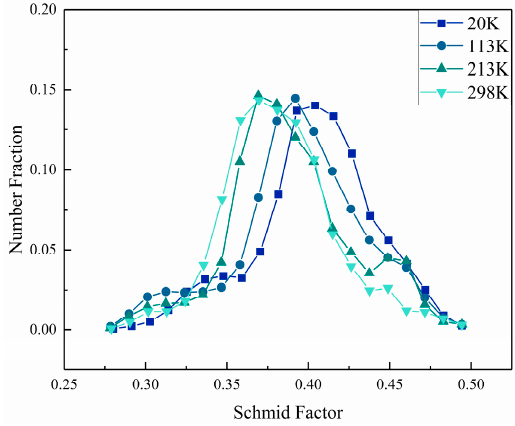
Figure 8. Schmid Factor of fractured samples at di ff erent temperatures